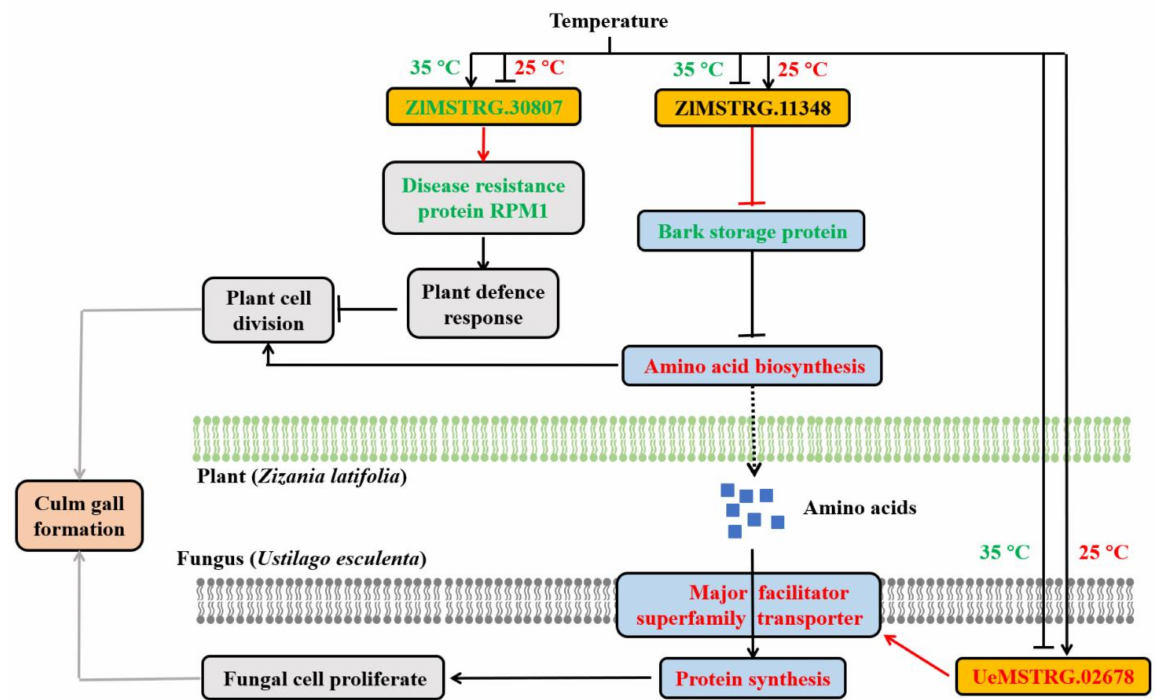
Figure 8. Hypothetical model of temperature-dependent culm gall formation. Under lower temperature (25 ◦ C), the ex-pression of lncRNA ZlMSTRG.30807 is suppressed resulting in down-regulation of gene encoding disease resistance pro-tein RPM1 and inhibition of the plant defence response, which induces plant cell division in Zizania latifolia infected with Ustilago esculenta . The expression of lncRNA ZlMSTRG.11348 may be induced in Z. latifolia infected with U. esculenta and it may negatively regulate the expression of the gene encoding bark storage protein, which further induces amino acid biosynthesis under cooler temperatures. These amino acids may not only provide nutrients for plant cell division but also be obtained by U. esculenta through the major facilitator superfamily transporter, which is positively regulated by lncRNA UeMSTRG.02678, and further be used for protein synthesis in fungal cell proliferation. These events induce culm gall formation in Z. latifolia infected by U. esculenta under decreased temperatures. High temperature (35 ◦ C) may inhibit the expression of lncRNA ZlMSTRG.11348 and induce the expression of lncRNA ZlMSTRG.30807 causing inhibition of amino acid metabolism and induced plant defence response in Z. latifolia . The expression of lncRNA UeMSTRG.02678 and its cis -target gene encoding major facilitator superfamily transporter is also suppressed in U. esculenta . These largely inhibits culm gall formation. Red and green indicate increased and decreased expression levels of genes or pathways, wherein most genes are up-regulated and down-regulated, in Z. latifolia infected by U. esculenta grown at 25 ◦ C, respectively. Red arrows indicate the predicted regulation between lncRNAs and their cis -target